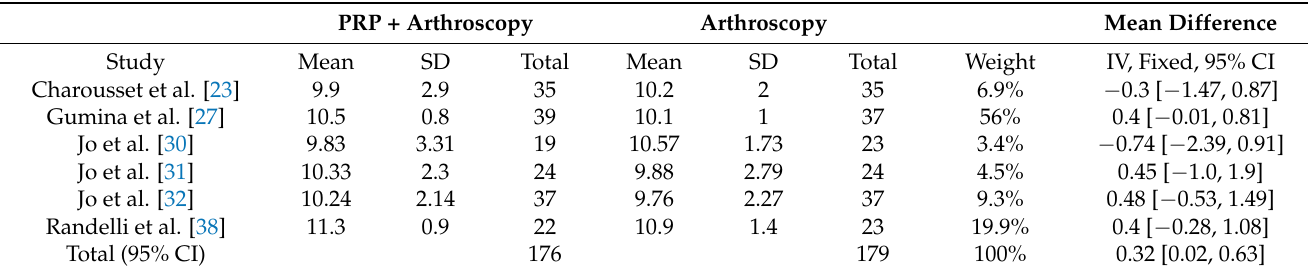
Table 5. Comparison of post-operative SST scores between PRP and control groups at final follow-up. PRP + Arthroscopy Arthroscopy